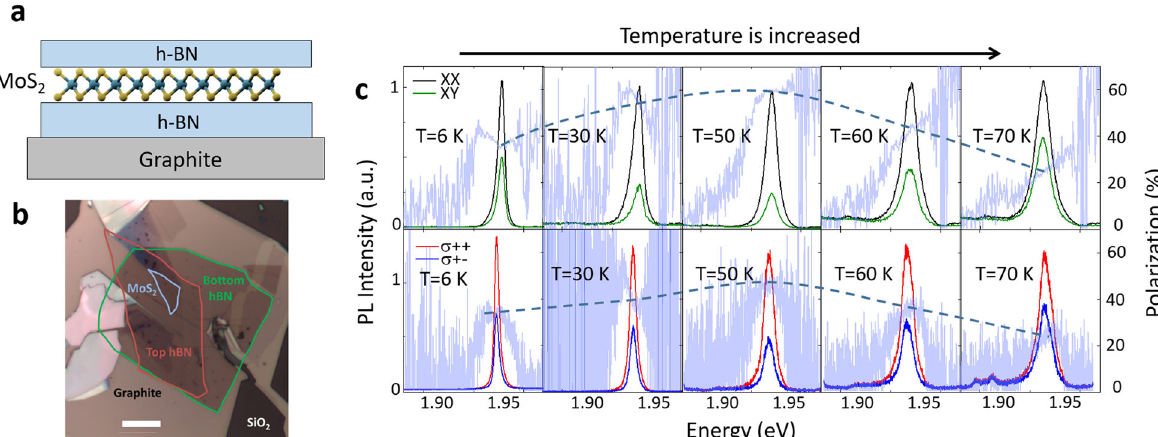
Fig. 1 Temperature dependence of valley polarization and coherence of monolayer MoS 2 . a Schematic side-view of the sample. The MoS 2 monolayer is encapsulated between two thin h-BN fl akes to provide high-optical quality and to prevent photodoping effects. A thin graphite fl ake is used to screen charge disorder from the substrate and to avoid back re fl ections for PL imaging. The whole heterostructure is deposited onto a silicon substrate with a 90 nm-thick silicon dioxide layer. b Microscope image of the sample. The length of the scale bar is 10 μ m. c Polarization-resolved PL spectra under linear (top) and circular (bottom) excitation at 1.96 eV for different sample temperatures. The excitation power was kept at 20 μ W. Also shown is the degree of polarization as a function of photon emission energy. The dashed lines are a guide to the eye indicating the polarization at the energy at which the PL intensity is